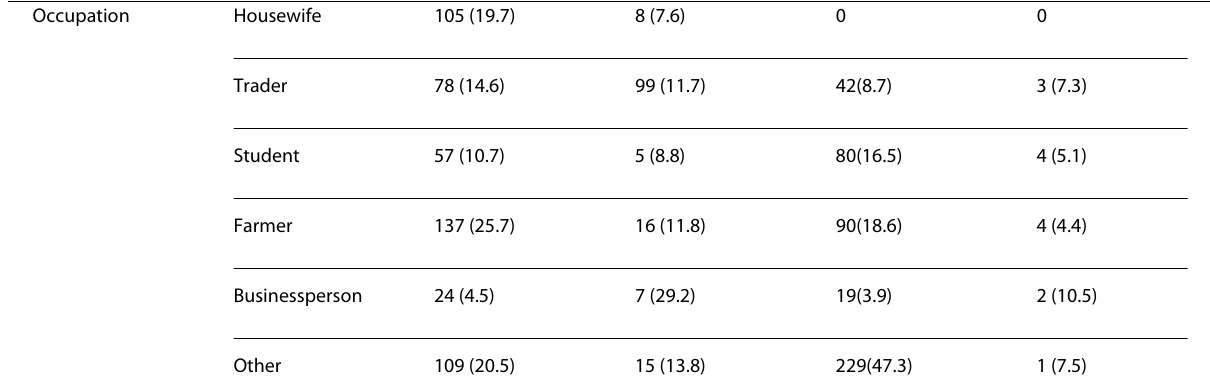
Table 2: Non-antenatal population: Characteristics and HIV prevalence, by sex